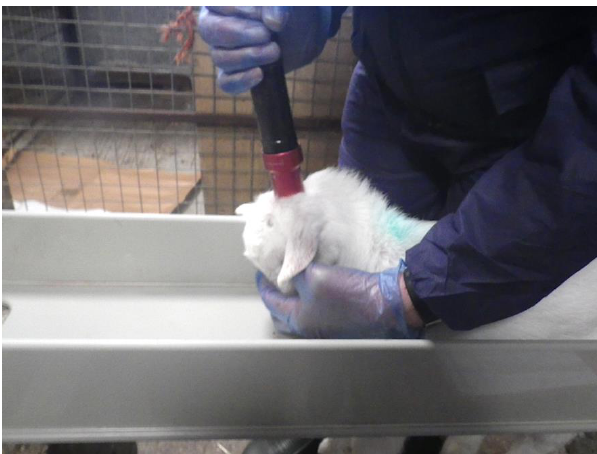
Figure 2. Restrainer in use (revised shot position technique, see below).